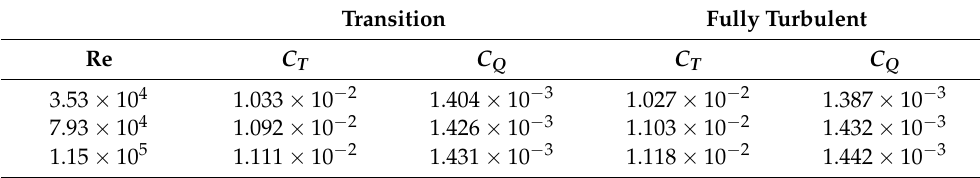
Table 3. Thrust and torque coefficients for fully turbulent and ransition-turbulence models.